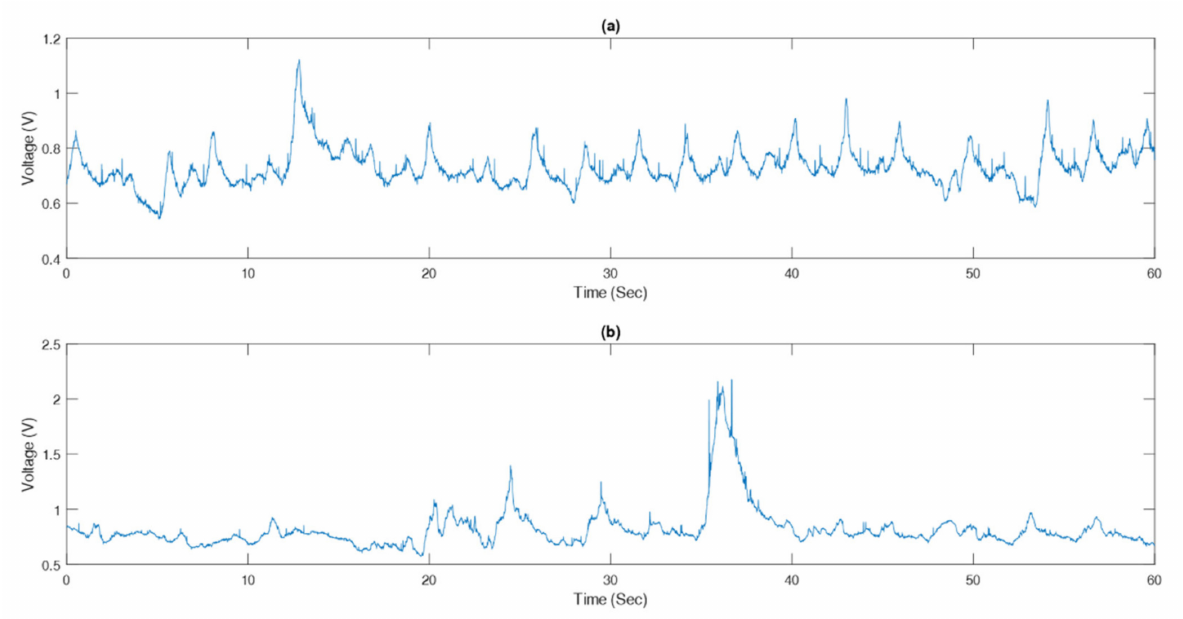
Figure 6. Samples of raw respiratory signals acquired by the IJPT on COPD patient while standing: ( a ) Good signal (test subject #8) and ( b ) deformed signal (test subject #10).